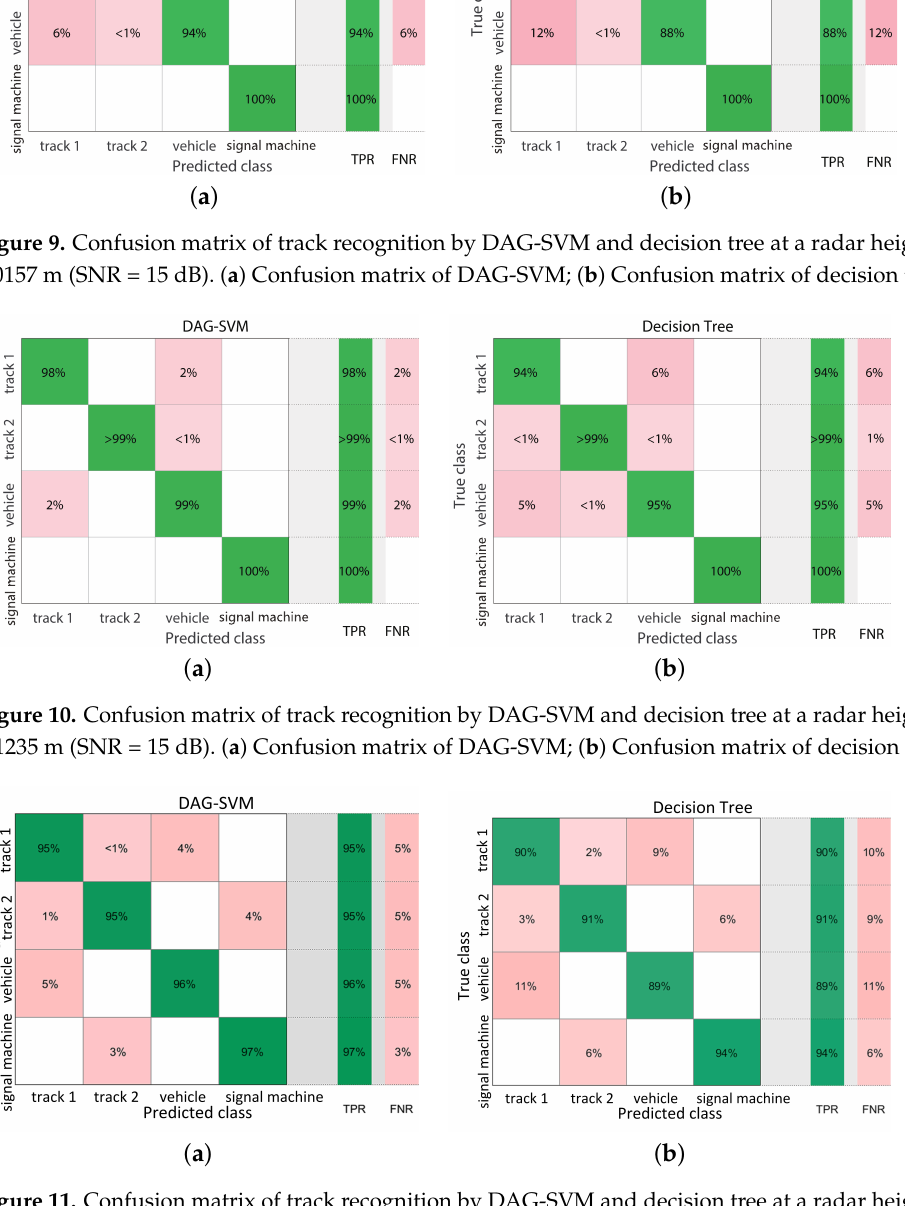
Figure 11. Confusion matrix of track recognition by DAG-SVM and decision tree at a radar height of 2.1235 m. (SNR = 7.5 dB). ( a ) Confusion matrix of DAG-SVM; ( b ) Confusion matrix of decision